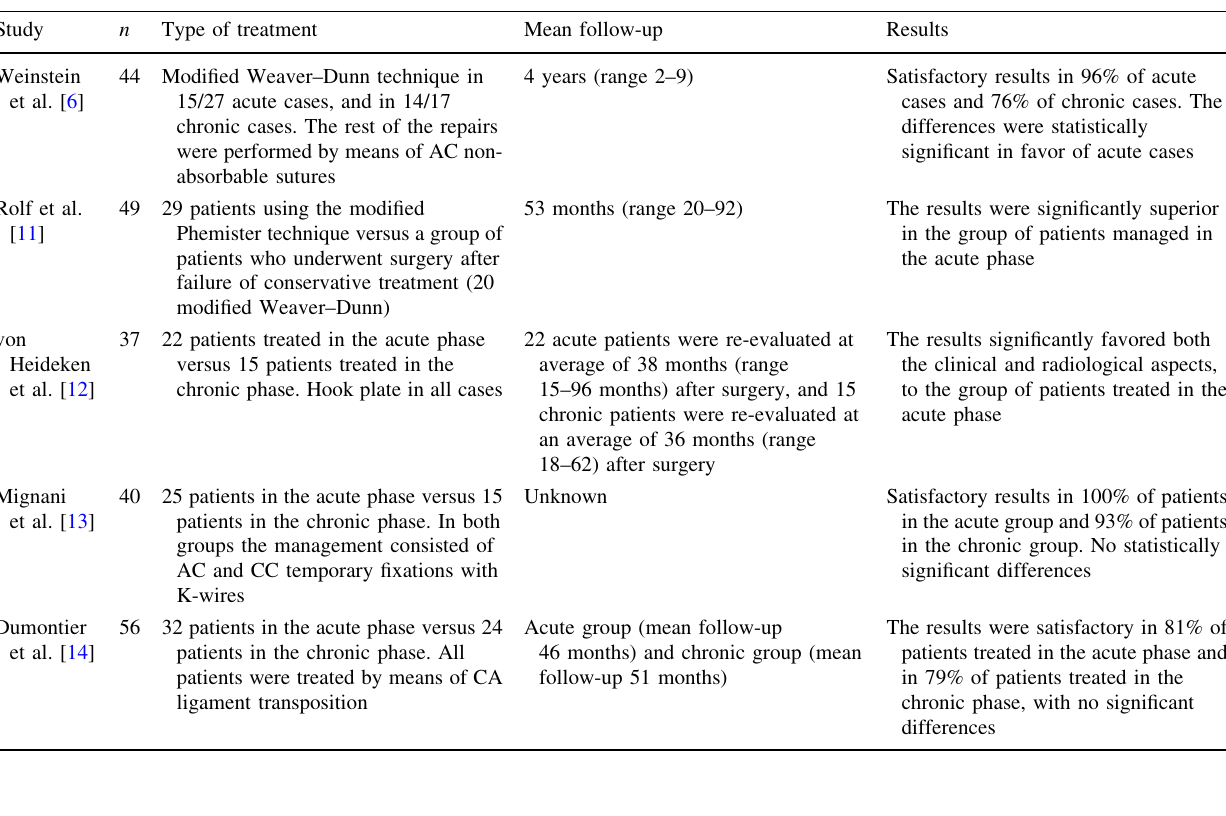
Table 1 Management in the chronic setting versus management in the acute setting